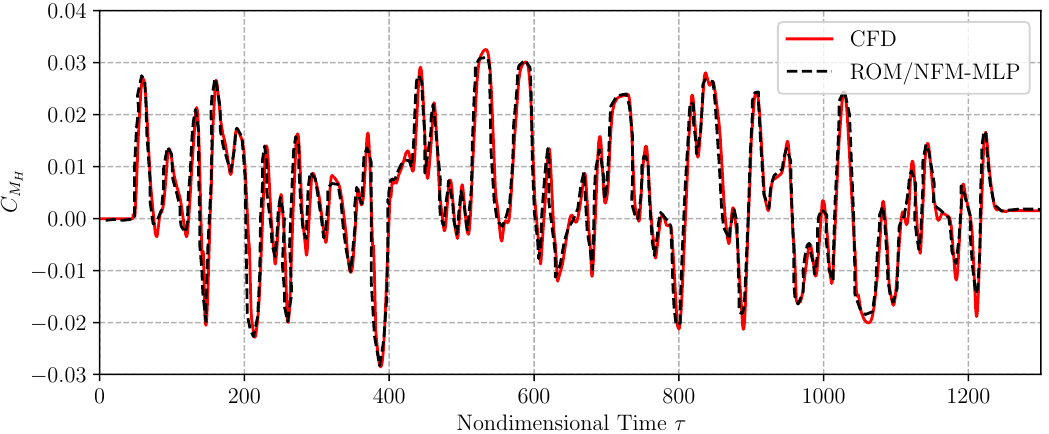
Figure 7. Hinge moment coefficient response caused by the APRBS excitation (NACA65 1 213 airfoil, Ma ∞ = 0.82, Re = 20.7 10 6 , α = 1 ◦ , δ = 12 ◦ ). Besides the CFD reference solution, the simulation × − ± result of the NFM-MLP ROM is shown.